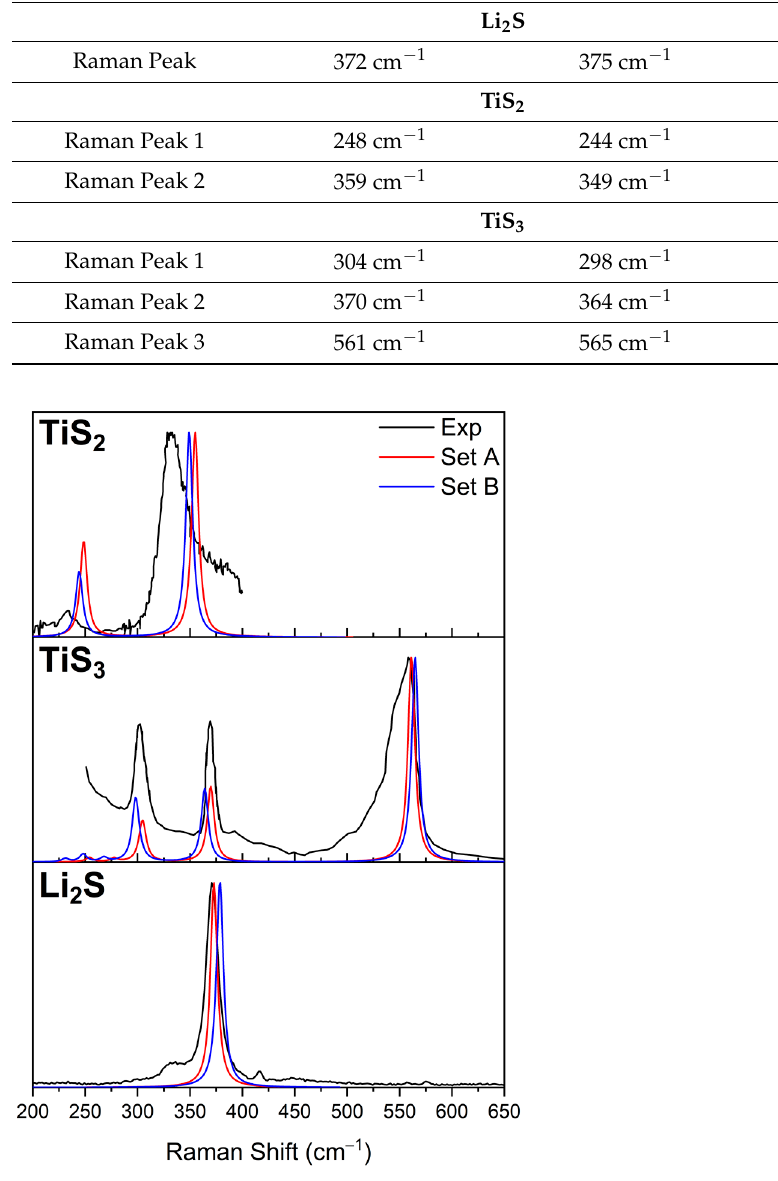
Table 2. Raman data. Simulated Raman peaks are compared with the data available in the literature.